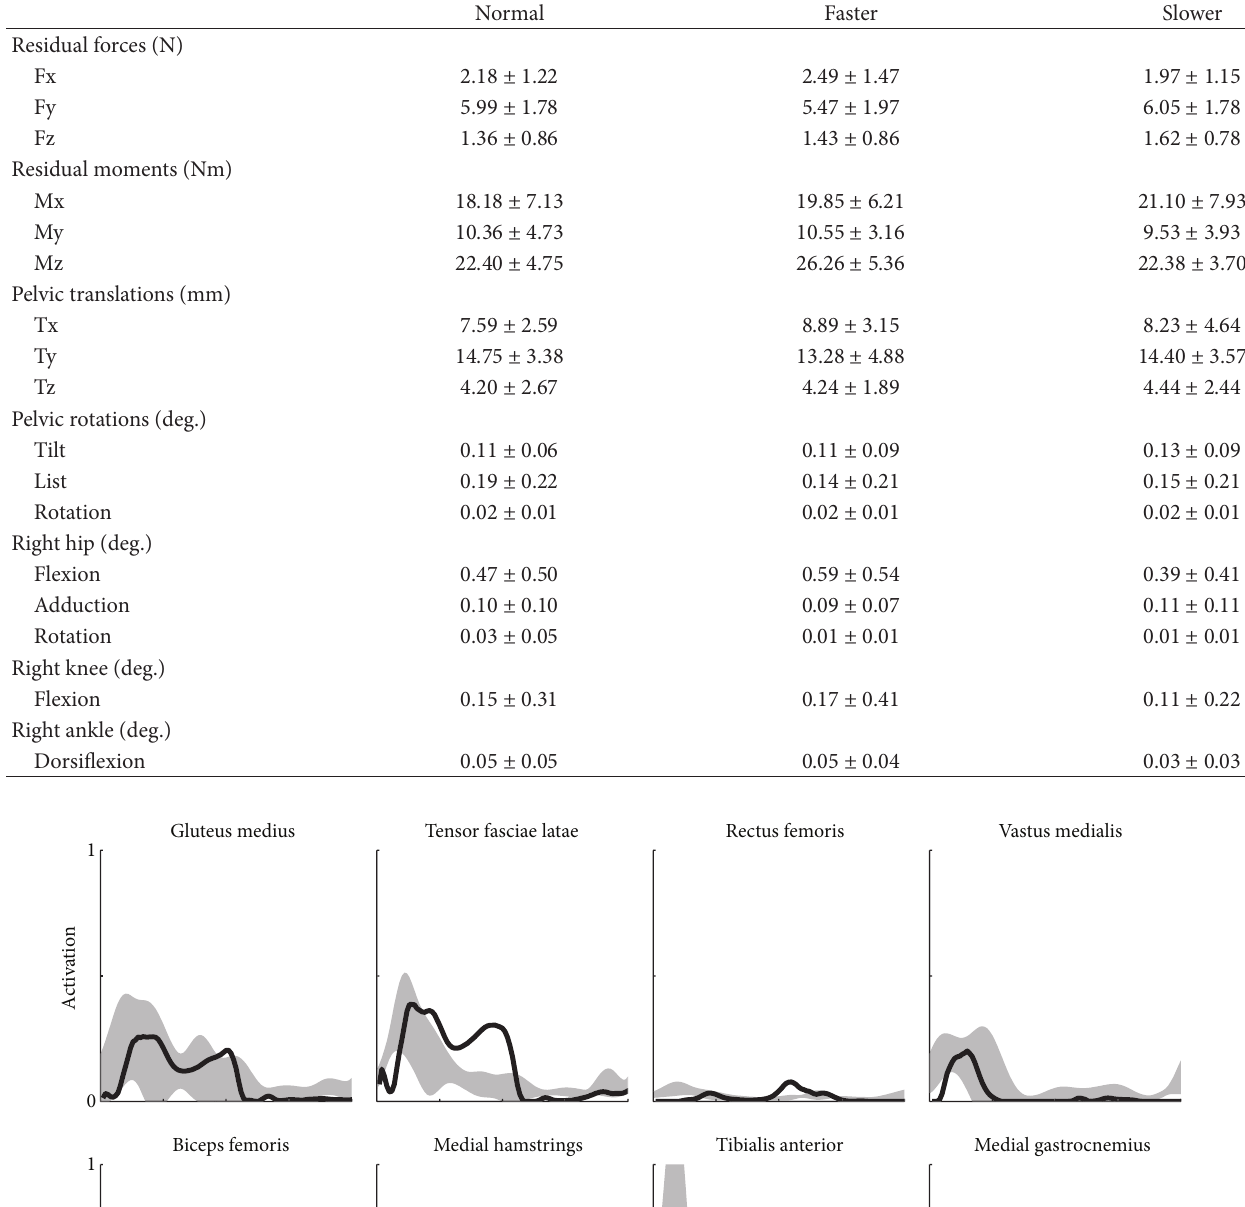
Table 1: Mean ± SD rms residual forces and moments and rms positional error of modeled kinematics for each condition. Normal